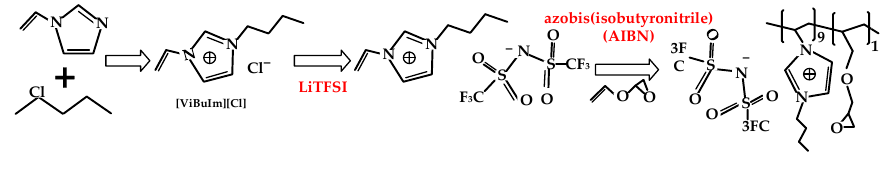
Figure 8. Synthesis process of cPIL.